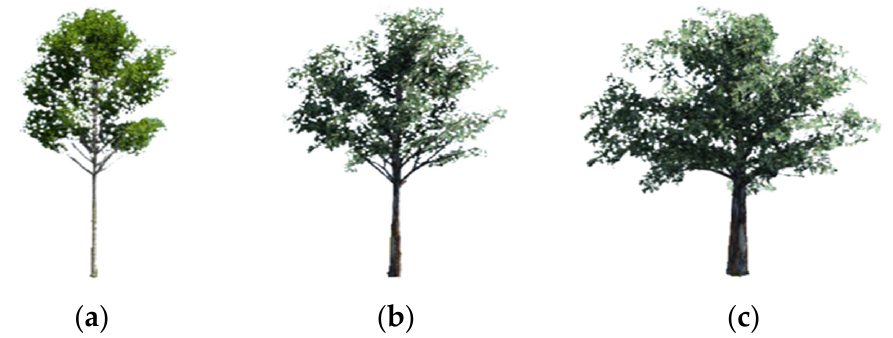
Figure 2. Examples of plants changing with age: ( a ) the current state; ( b ) three years later; ( c ) five years later.